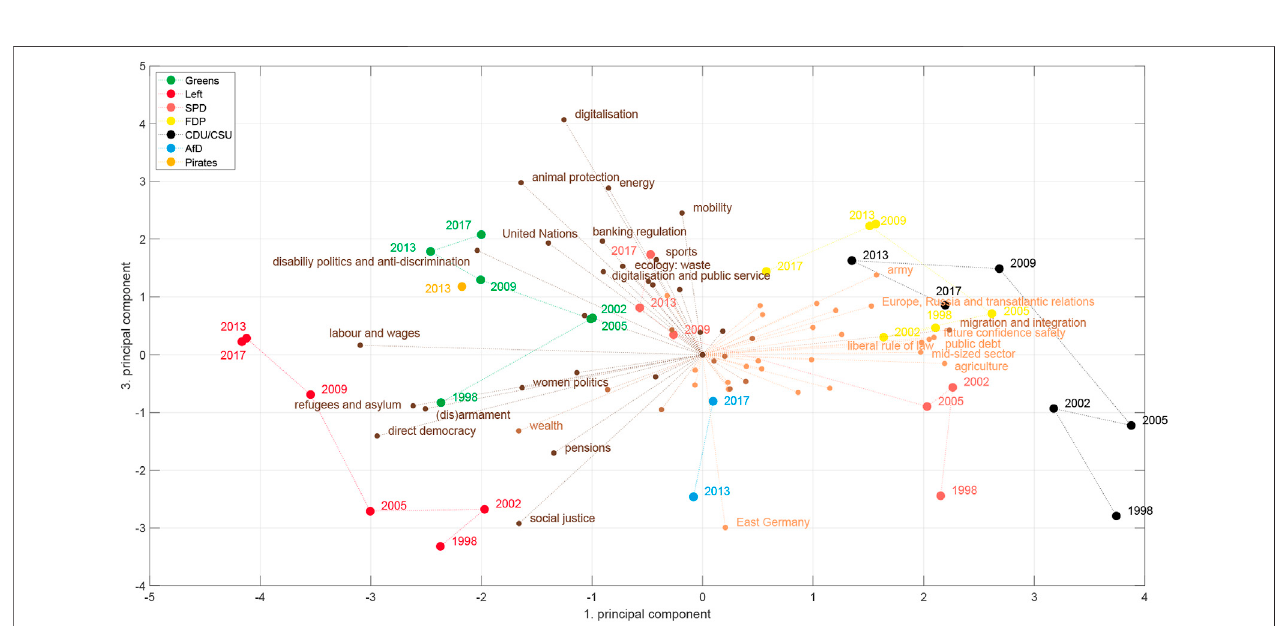
FIGURE 10 | Same as in Figure 9 but now for the 1st and the 3rd principal component.